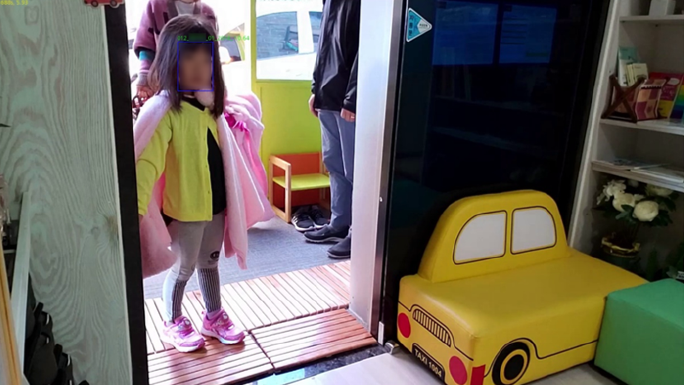
Figure 18. Test video used in experiment 2.